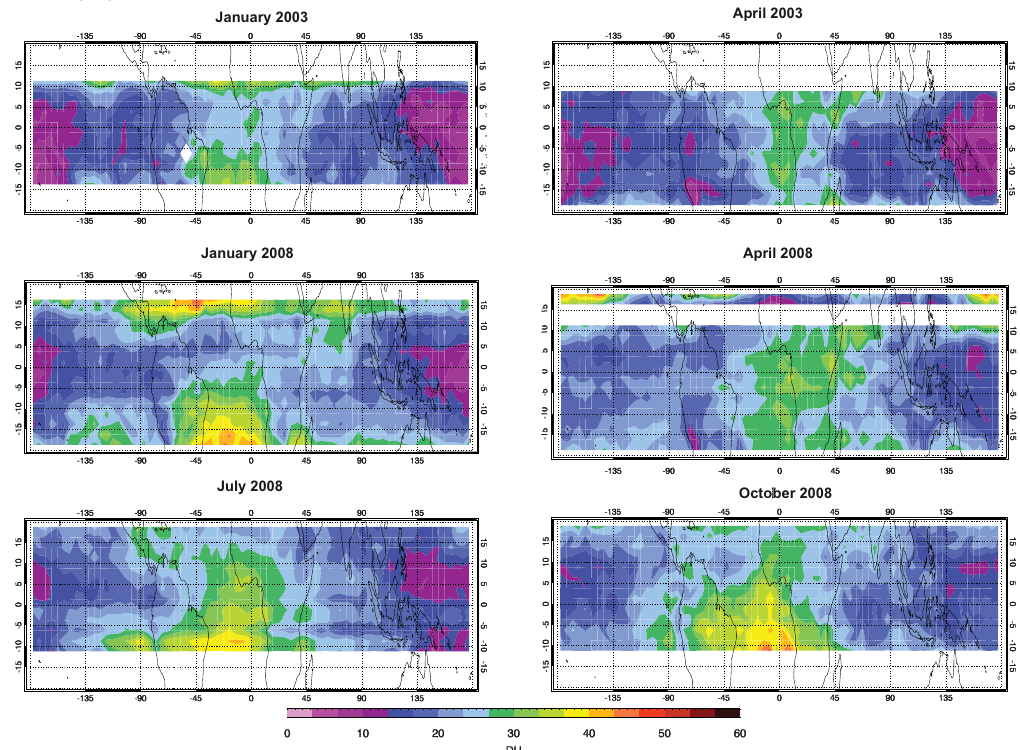
Figure 10. Tropical tropospheric ozone column (TTCO) derived with the convective cloud differential (CCD) technique for January and April 2003 and January, April, July, and October 2008 using SCIAMACHY data.